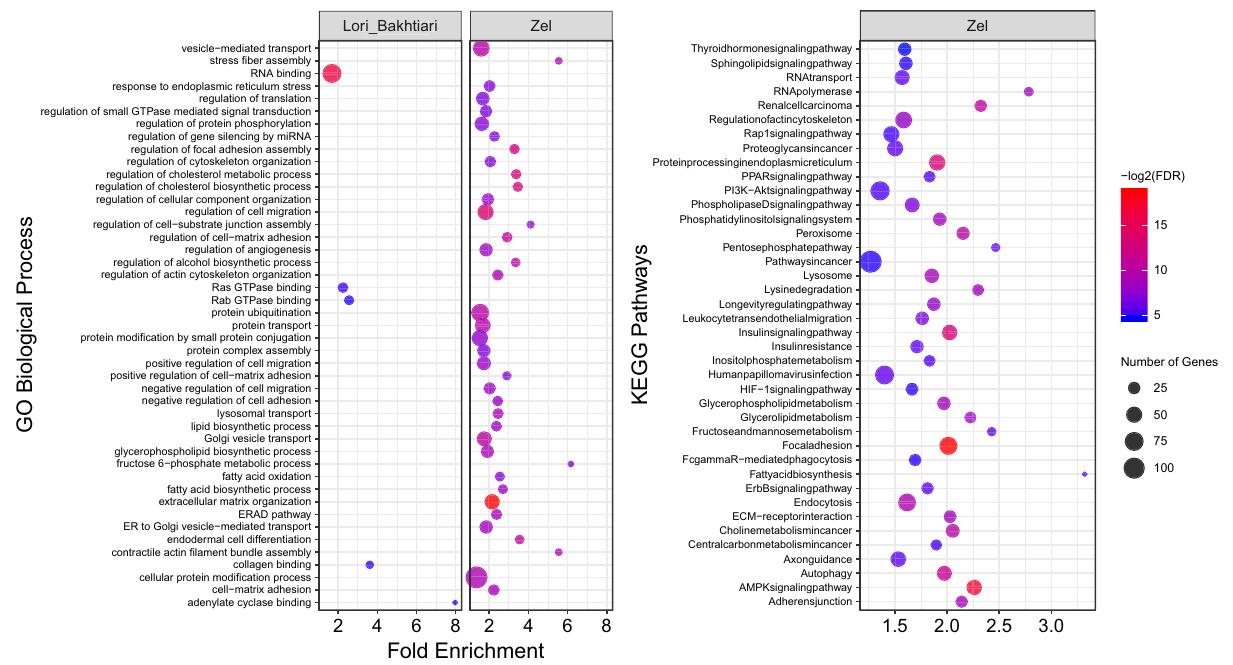
Figure 5. Functional enrichment analysis results. Because of the large number of significant GO terms (biological process) and KEGG pathways found in Zel breed, only the top 40 significant terms are displayed. Size and color of points represent -Log2 of FDR and number of genes associated with each term,